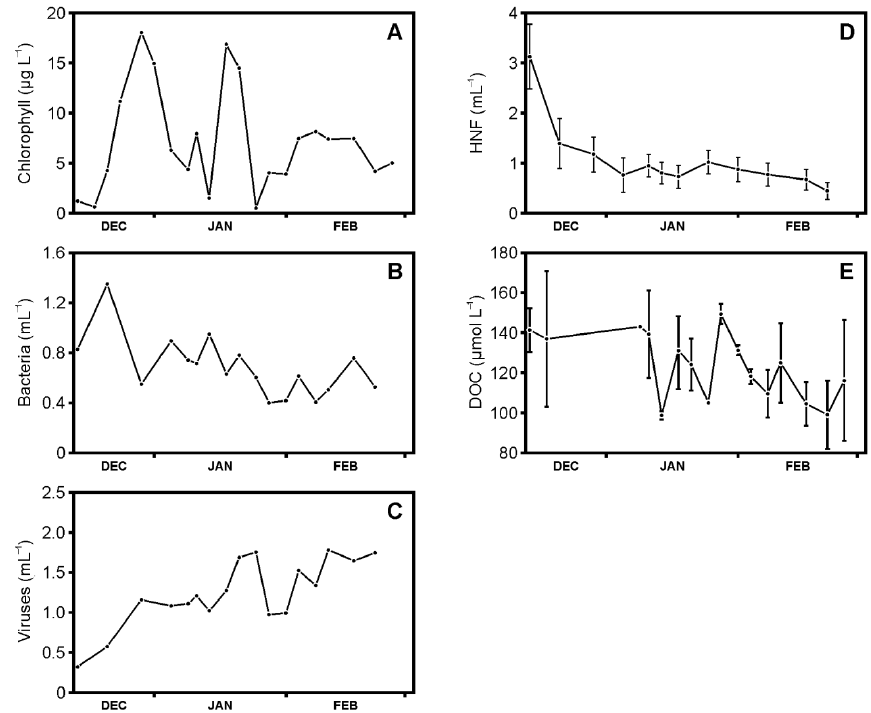
Figure 2. Plankton abundances and dissolved organic carbon (DOC) concentrations during the austral summer (December 2010 to February 2011) at the western Antarctic Peninsula sampling site at a water depth of 15 m: ( A ) chlorophyll concentrations are representative of phytoplankton levels, ( B ) abundances of bacterioplankton, ( C ) virioplankton, ( D ) heterotrophic nanoflagellates (HNFs), and ( E ) concentrations of dissolved organic carbon (DOC). HNF and DOC concentrations are averages of triplicate measurements with the error bar representing the standard